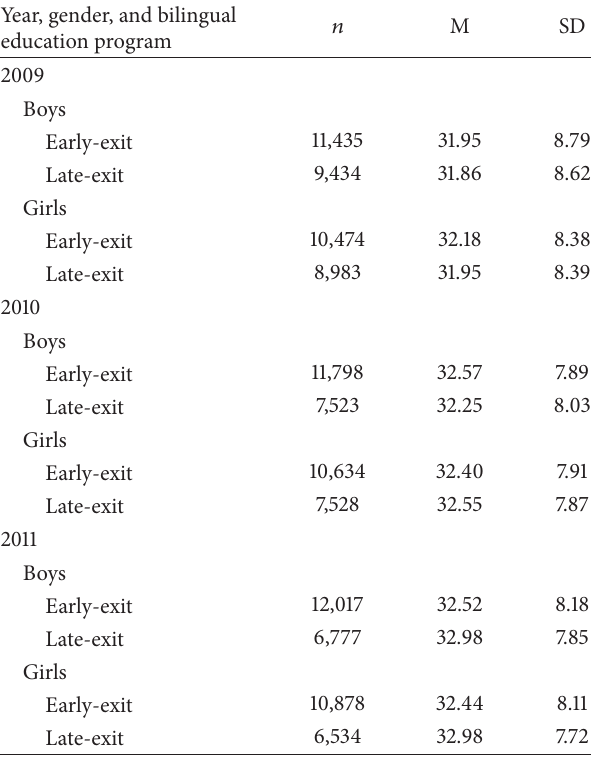
Table 6: Descriptive statistics for the 2009, 2010, and 2011 TAKS Mathematics scores for Grade 4 Boys and Girls by bilingual education